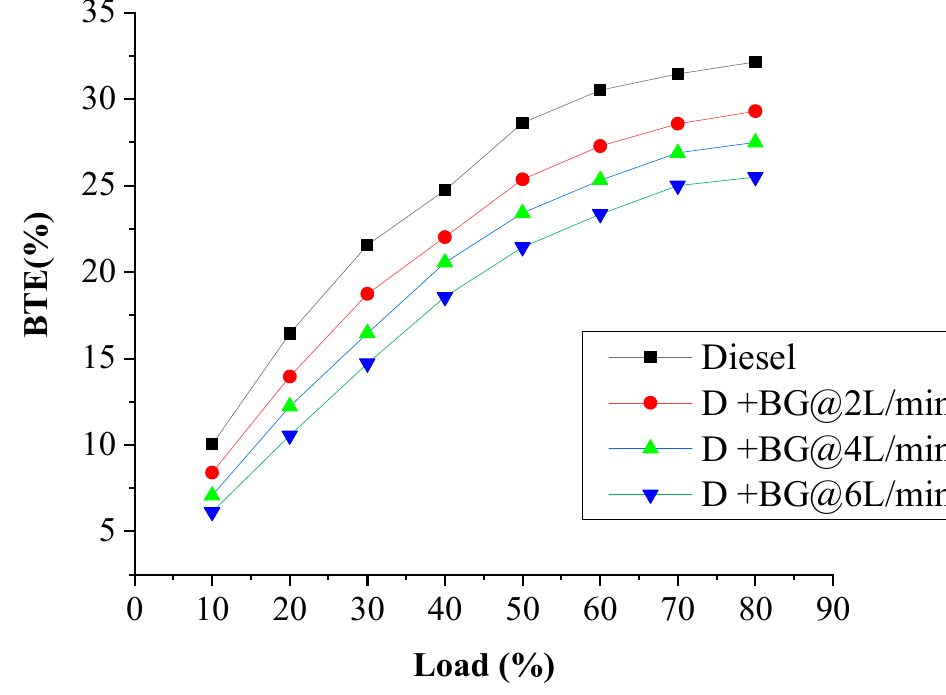
Figure 5. Variation of BTE with respect to engine load.